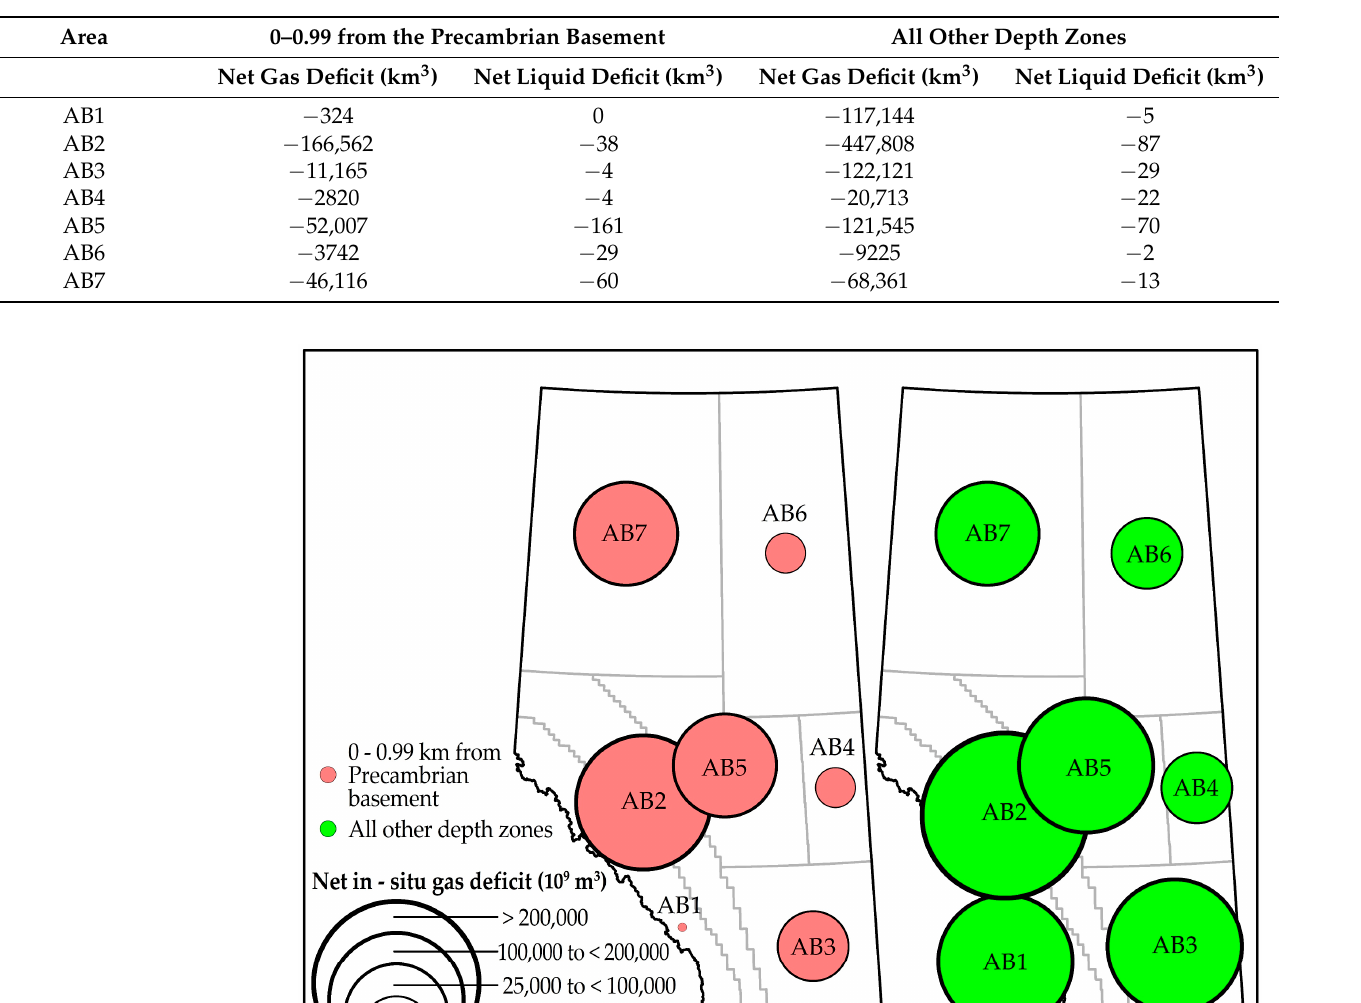
Table 4. Calculated net in situ fluid deficits in the Alberta Basin (as of 31 December 2020). Source data extracted from geoLOGIC Systems databases © 2020.